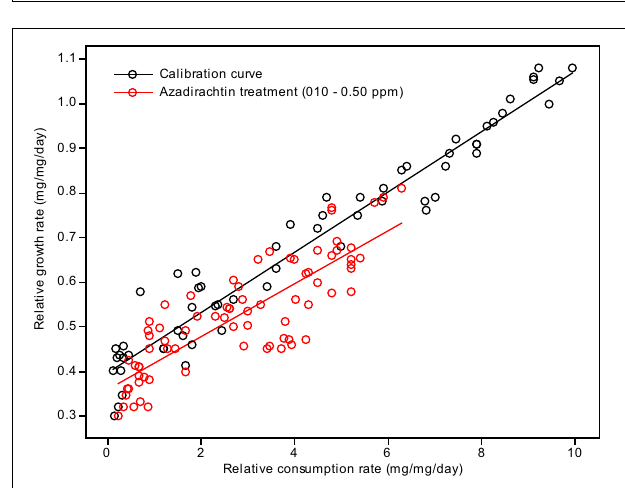
FIGURE 2 | Correlation between the relative consumption rates and relative growth rates of C. medinalis fed on different quantities of control diet (calibration curve) and larvae fed on diet containing different concentrations of azadirachtin.